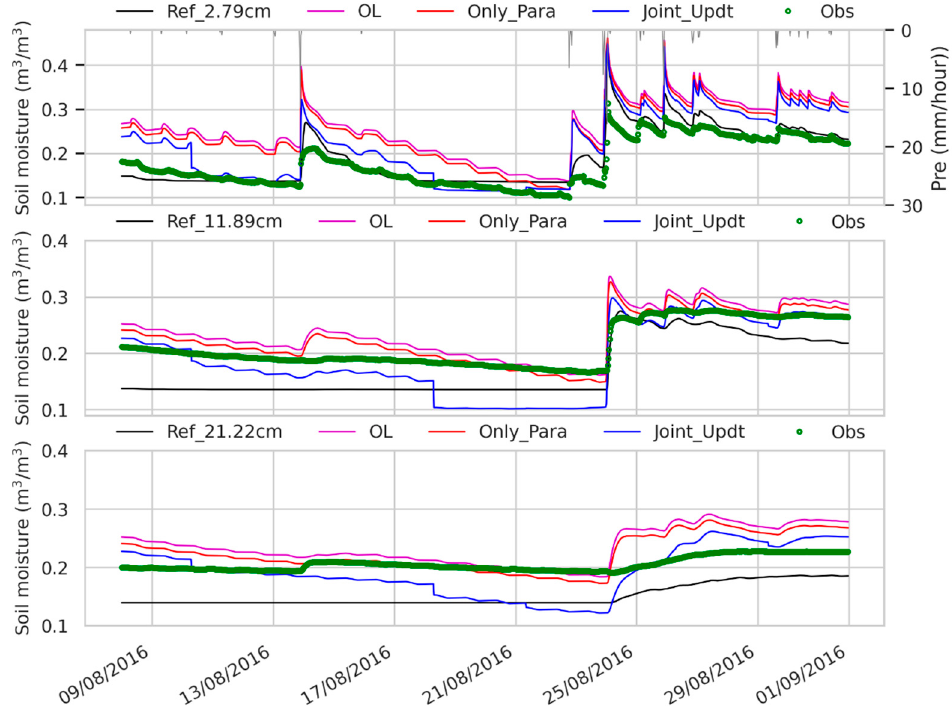
Figure 7. Soil moisture time series from 7 August 2016 to 31 August 2016 of the second (2.79 cm), third (11.89 cm) and fourth (21.22 cm) layers in the reference (Ref), open loop (OL) experiments, experiment with only soil properties updated (Only_Para) and experiment with both soil properties and soil moisture estimates (Joint_Updt) by assimilating SMAP T H . Obs denotes profile soil moisture measured by 5TM ECH2O probes deployed at the ELBARA-III radiometer region on the Maqu site [38].